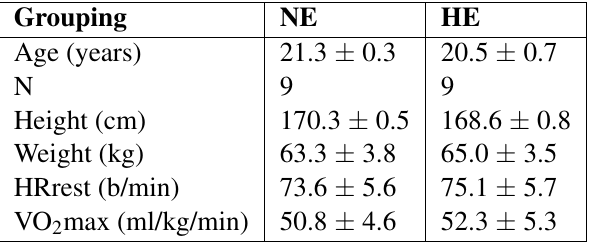
Table 1 Basic situation and grouping of